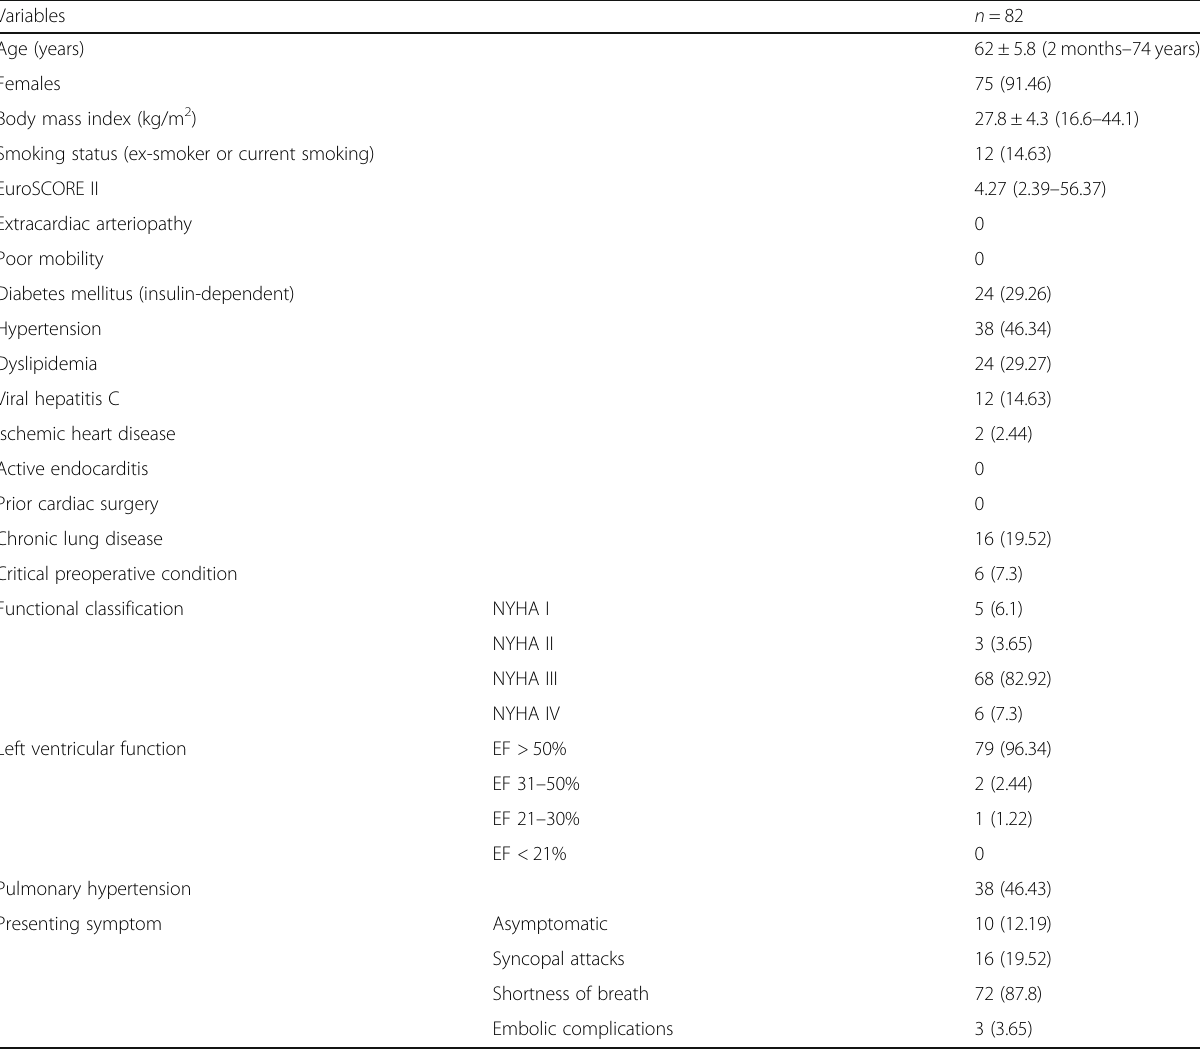
Table 1 Preoperative characteristics of the study patients